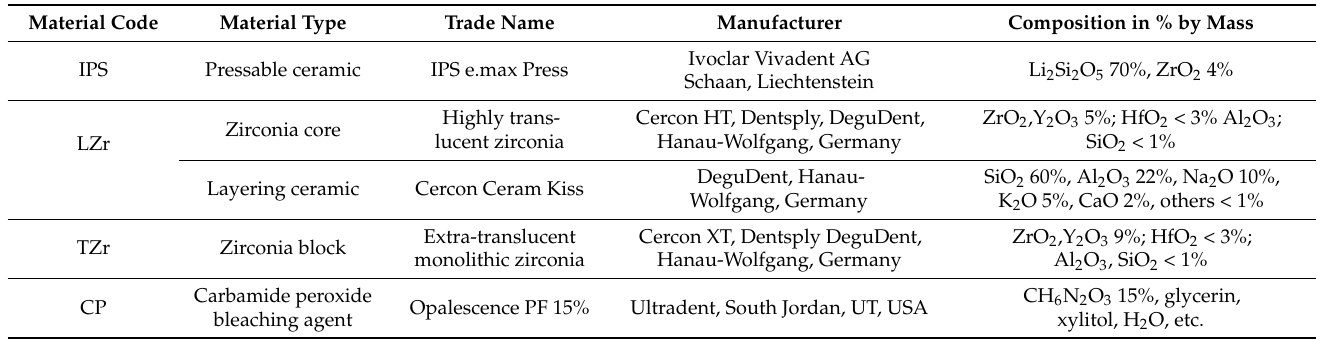
Figure 1. Disk-shaped specimens measuring 20 × 3 mm from one group of materials. Table 1. Details of the materials used in the research study.